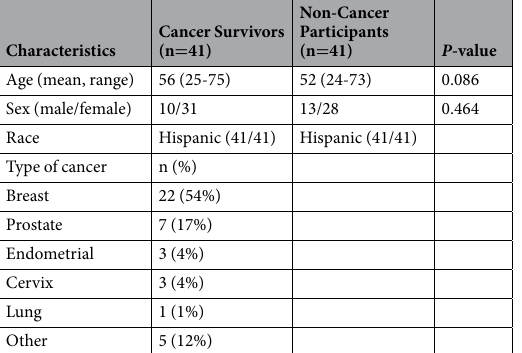
Table 1. Clinical and demographical measurements from study participants.